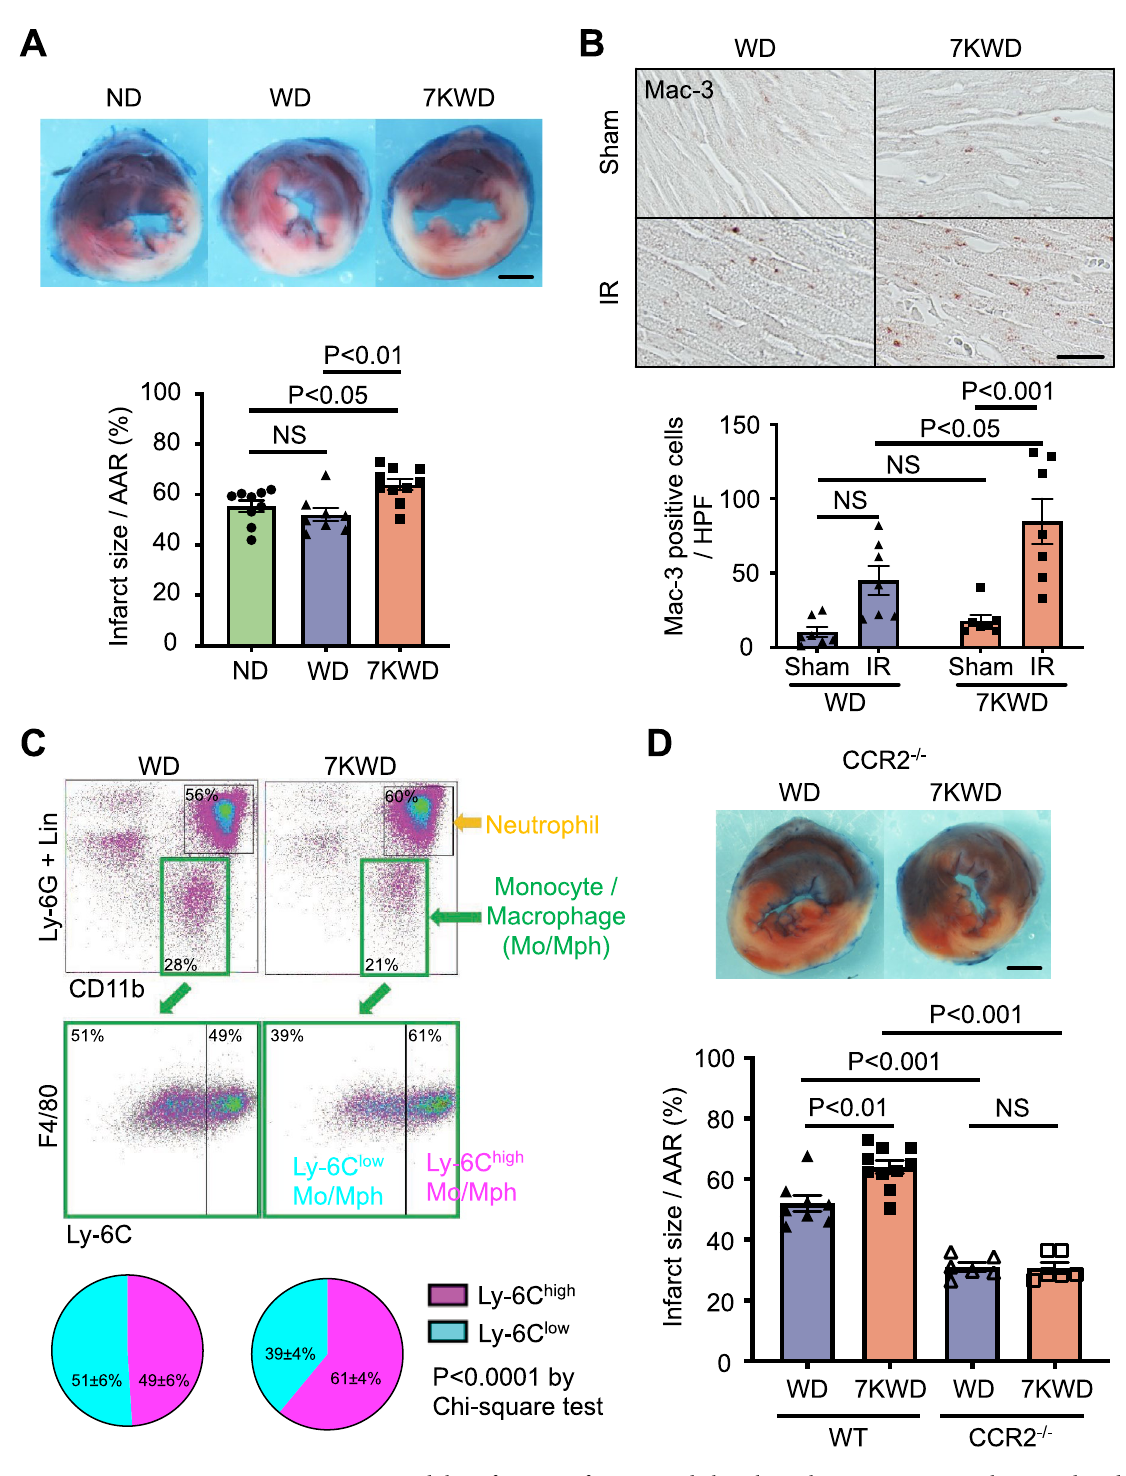
Figure 1. Dietary 7-KC increased the infarct size after myocardial IR through monocyte/macrophage-mediated inflammation. ( A ) Infarct size at 24 h after IR. Scale bar, 1 mm. N = 8–10. The data were analyzed by one-way ANOVA, followed by Tukey’s post-hoc multiple comparison test. ( B ) Macrophages (Mac-3-positive cells) in the heart at 24 h after IR. Scale bar, 20 µm. N = 7. The data were analyzed by one-way ANOVA, followed by Tukey’s post-hoc multiple comparison test. ( C ) Percentages of Ly-6C-high or Ly-6C-low monocytes/macrophages in the heart at 24 h after IR assessed by flow cytometry. N = 6. The data were analyzed by chi-square test. ( D ) Infarct size in WT and CCR2-deficient mice at 24 h after IR. The data of WT group was cited from ( A ) as the control. N = 6. The data were analyzed by one-way ANOVA, followed by Tukey’s post-hoc multiple comparison test. ND, normal laboratory diet; WD, Western diet; 7KWD, WD containing 7-KC; AAR, area at risk; IR, ischemia– reperfusion; Lin, lineage; Mo, monocyte; Mph, macrophage; CCR2 −/− , CCR2-deficient mice; WT, wild-type